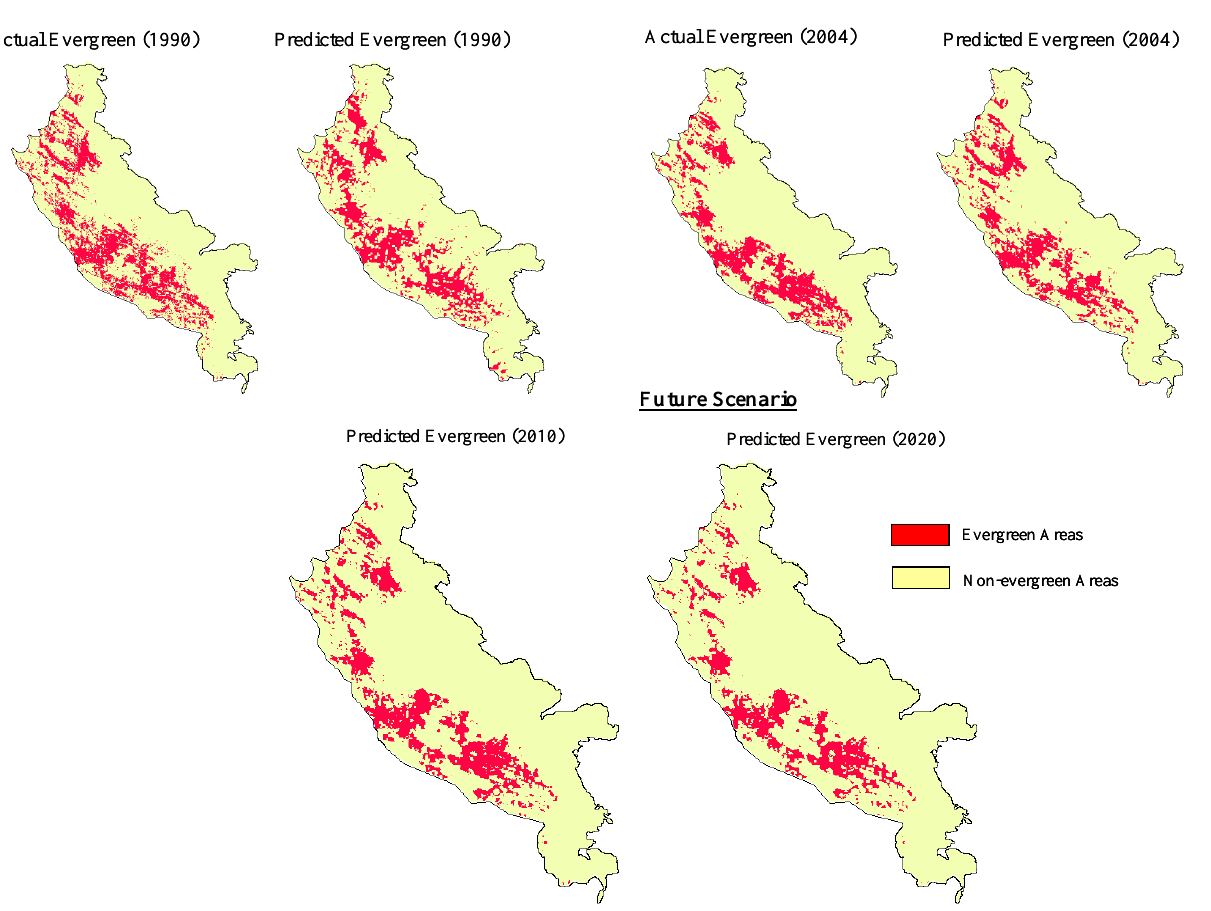
Figure 7. Comparison of actual and predicted evergreen forest change between 1990 & 2004 using GEOMOD modelling and also the future scenario map of 2010 & 2020 for the study region (KMTR), South Western Ghats, Tamil Nadu